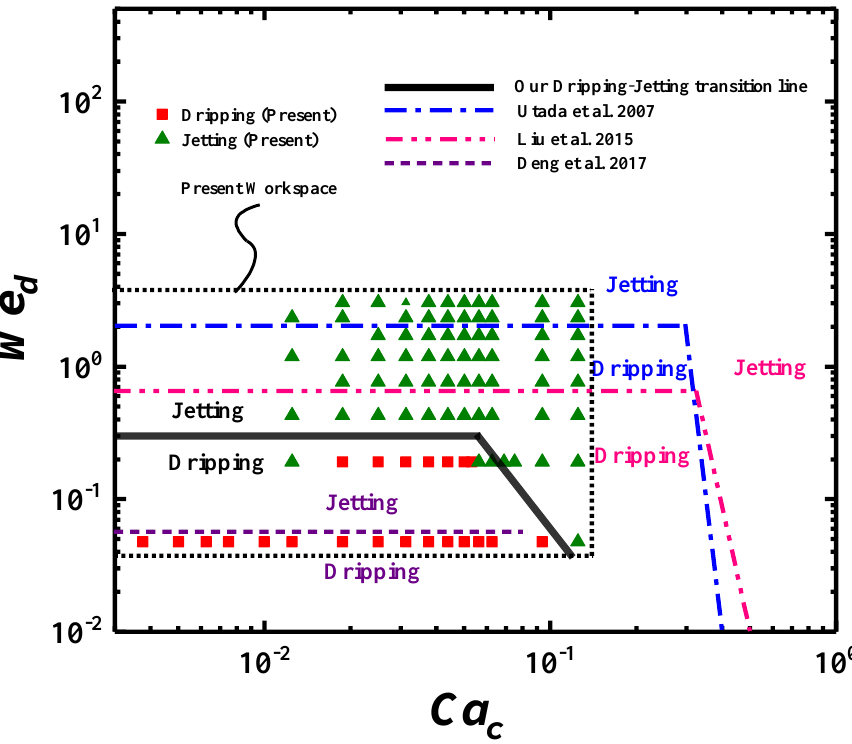
Figure 2. Comparisons of Dripping and Jetting on the flow pattern regions in ( Ca c , We d )